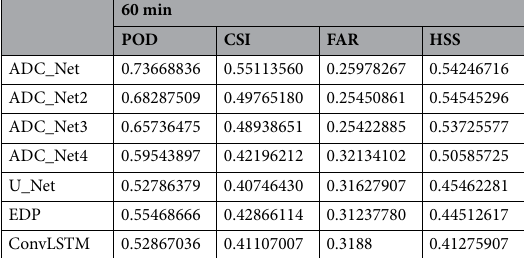
Table 2. 60-min radar echo extrapolation evaluation